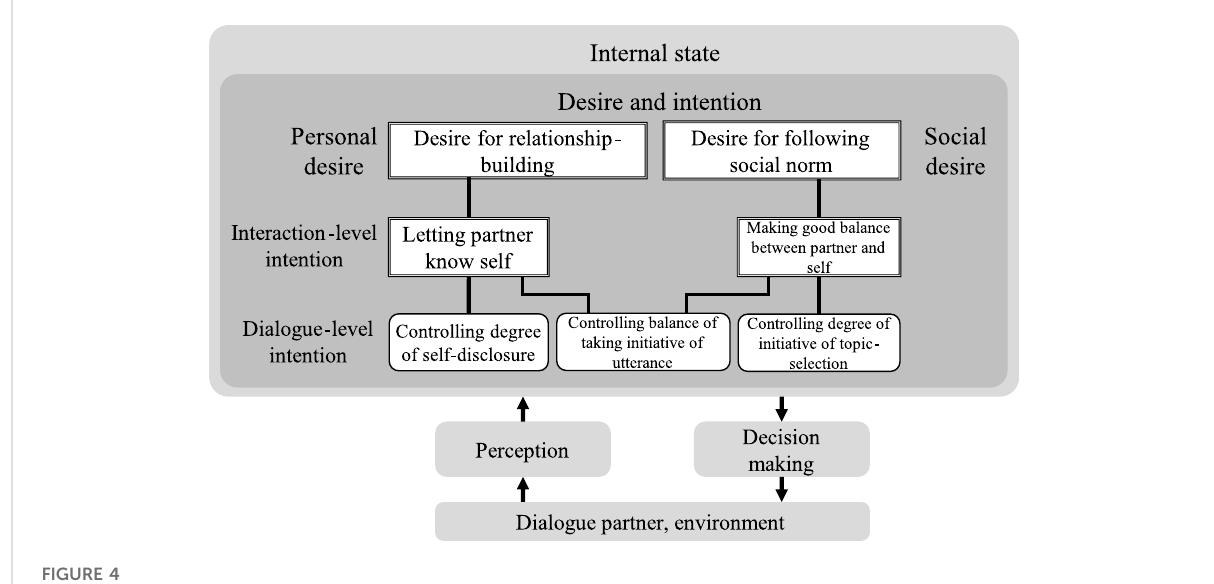
FIGURE 4 Principle for decision-making of the robot in the fi rst-meeting dialogue.